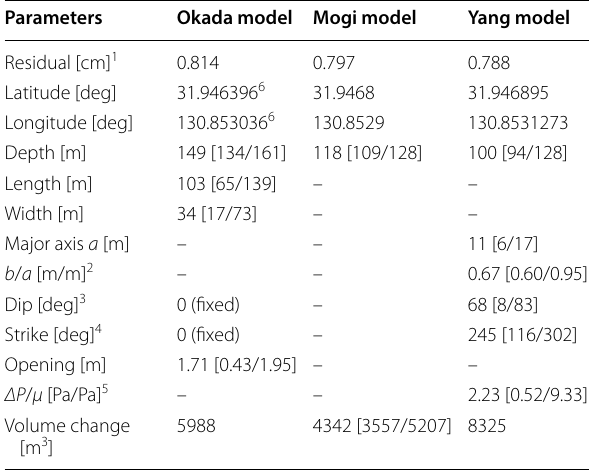
Table 2 Parameters of best-fit source models (August 2014–August